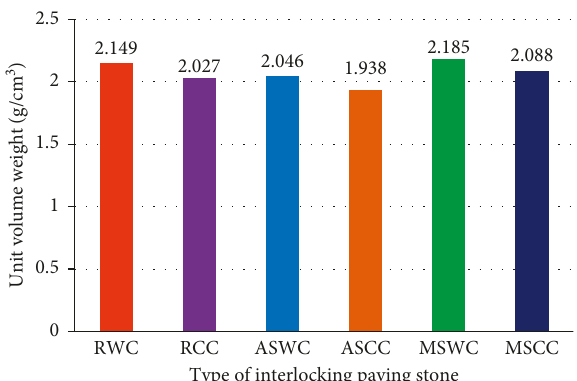
Figure 8: Unit volume weight of the locked paving stones.